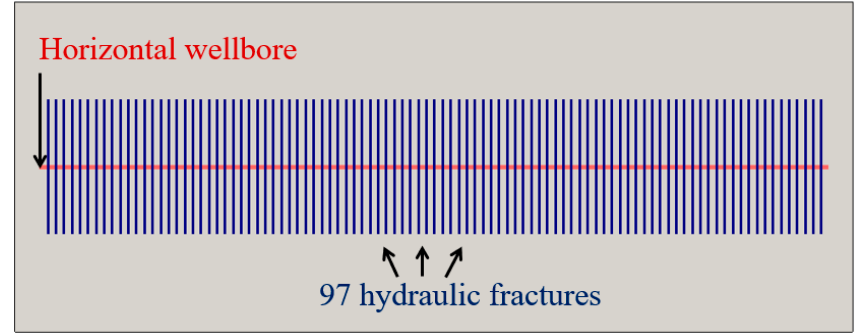
Figure 2. The field-scale shale-gas reservoir model with two-phase flow including one horizontal well and 97 hydraulic fractures.